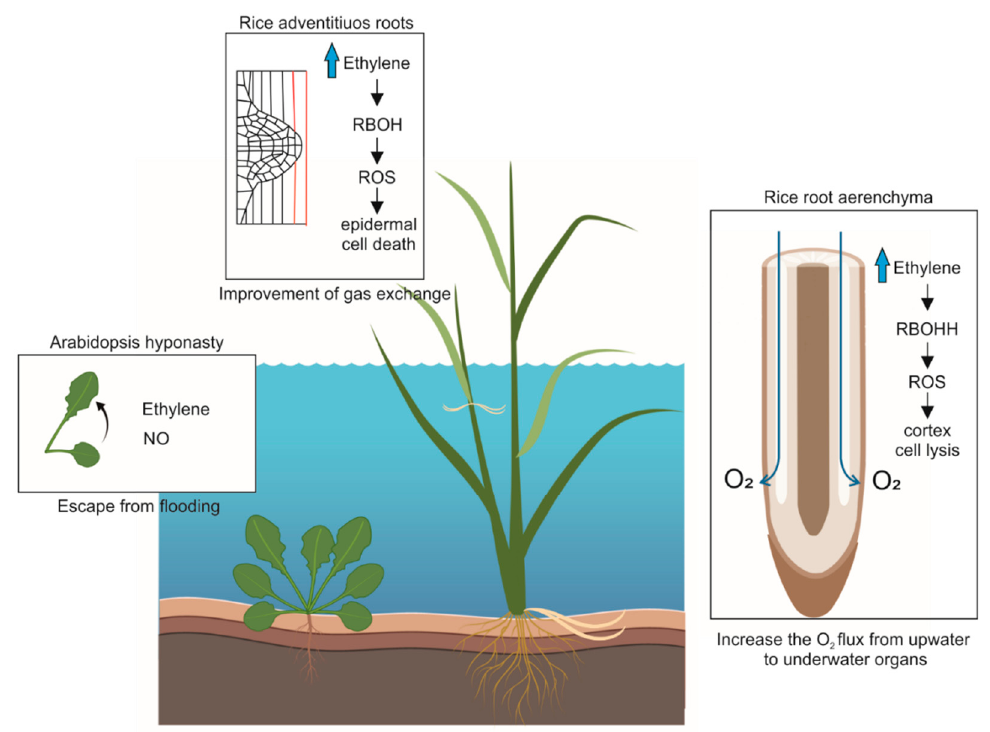
Figure 1. Role of reactive oxygen species (ROS) and nitric oxide (NO) in the environmental adaptation of plants to hypoxia: aerenchyma formation in rice [67], adventitious root emergence in rice [73], and leaf hyponasty in Arabidopsis [77]. The figure was created with